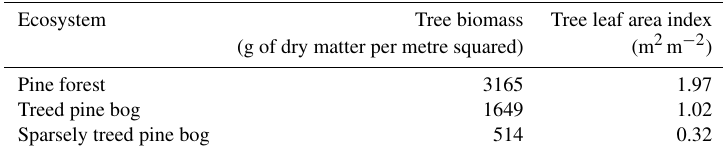
Table A5. Tree biomass and leaf area index derived from field and remote sensing measurements.